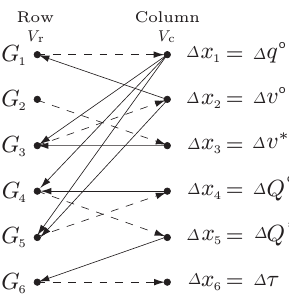
Figure 5. Directed bipartite graph.